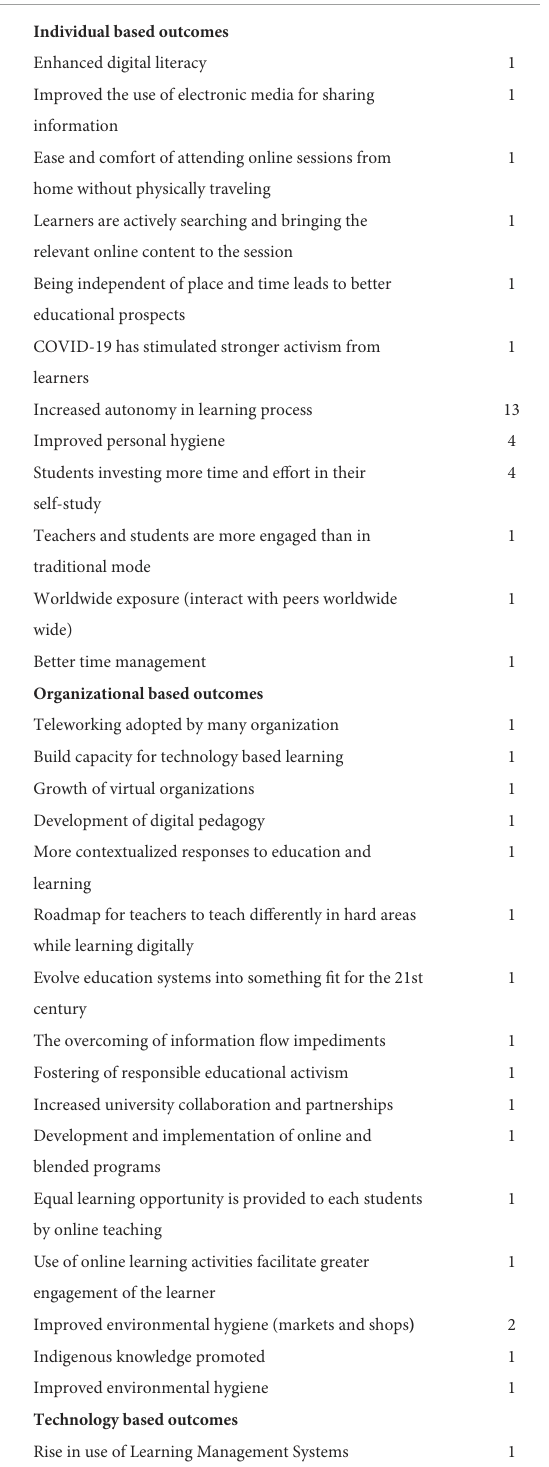
TABLE 11 Technology-based positive outcomes emerging from the COVID-19 pandemic. No. Silver linings emerging from COVID-19